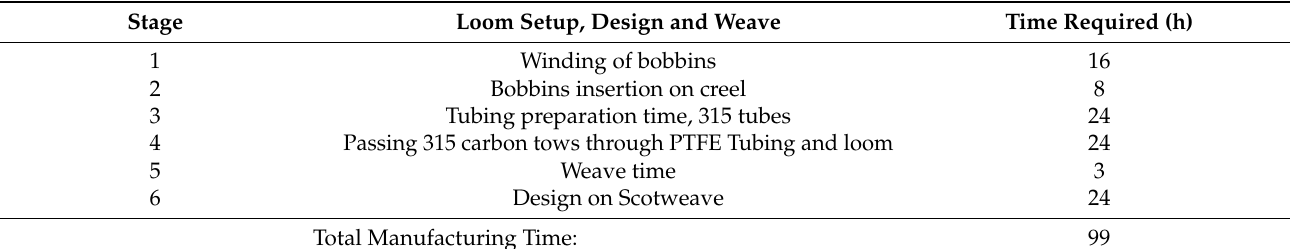
Table 4. Preform 4 setup and weave manufacturing